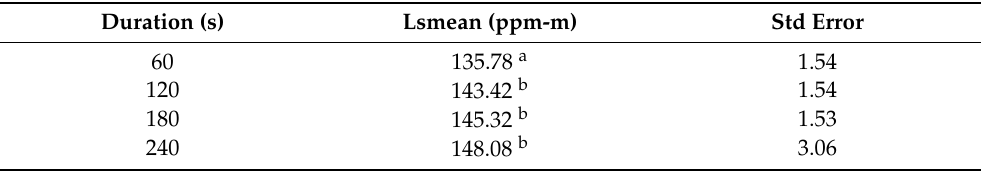
Table 4. Least square means of enteric methane measurements calculated from different measurement durations